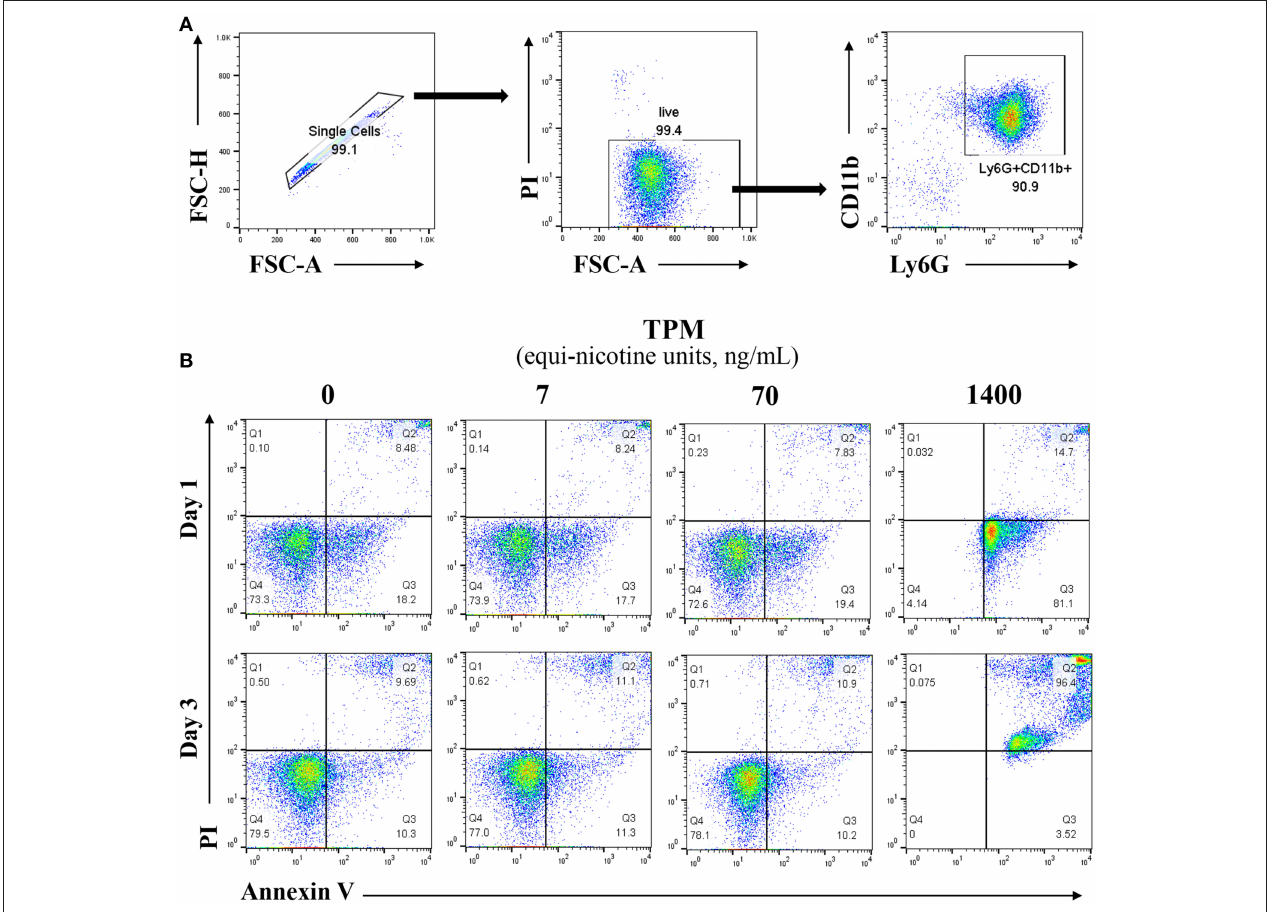
FIGURE 1 | Lower dosages of TPM do not increase neutrophil cell death. (A) Reprensentive flow cytometry analysis of viability and purity of isolated neutrophils from mouse bone marrow through percoll gradient as described in the Materials and Methods section. (B) Purified neutrophils were cultured in completed RPMI medium. Neutrophils were treated with different concentrations (ng/ml equi-nicotine units) of TPM for 3 days. Flow cytometry analyses were performed to measure cell death as described in the Materials and Methods section. Representative results from three experiments are shown. Numbers on dot plots represent the percentage of apoptotic neutrophils cells stained by PI and annexin